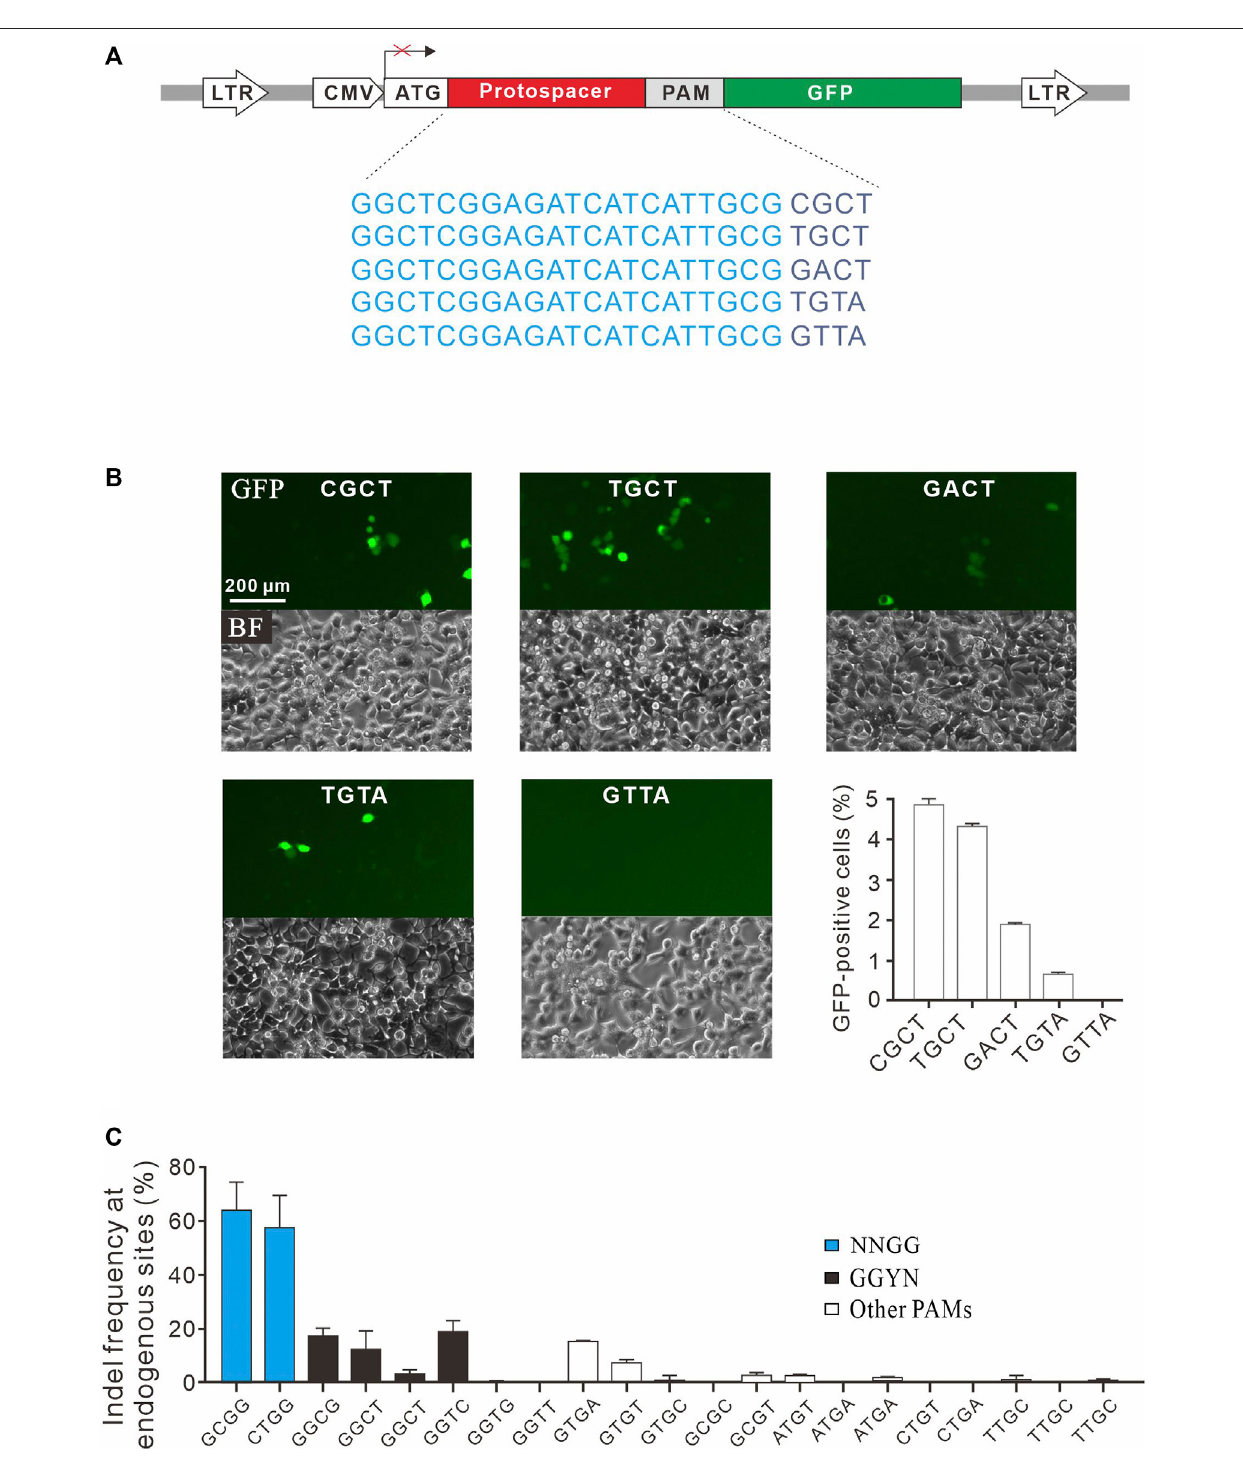
FIGURE 4 | Validation of noncanonical PAMs. (A) Schematic diagram of the GFP activation assay with fi ve targets shown below. (B) Five GFP reporter constructs with noncanonical PAMs are isolated from the PAM library and tested for genome editing. Quanti fi cation is shown on the bottom right. n (cid:1) 3. (C) Indel frequency of endogenous target sequences associated with noncanonical PAMs. n (cid:1) 3.